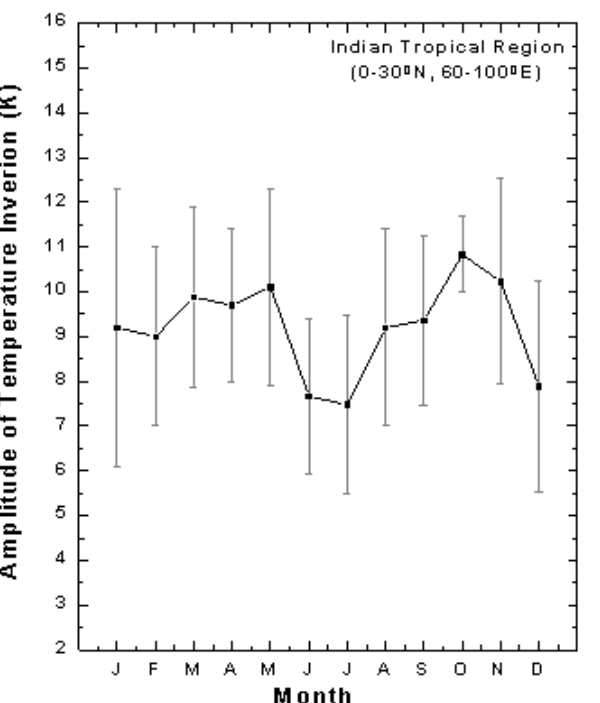
Fig. 3. Variation of monthly mean amplitude of temperature inver- sion (k) as obtained in this work using The HALOE temperature series over the Indian tropical region (0–30 ◦ N, 60–100 ◦ E) during the period 1991–2001. Vertical bar represents 2 sigma error at 95% confidence level.